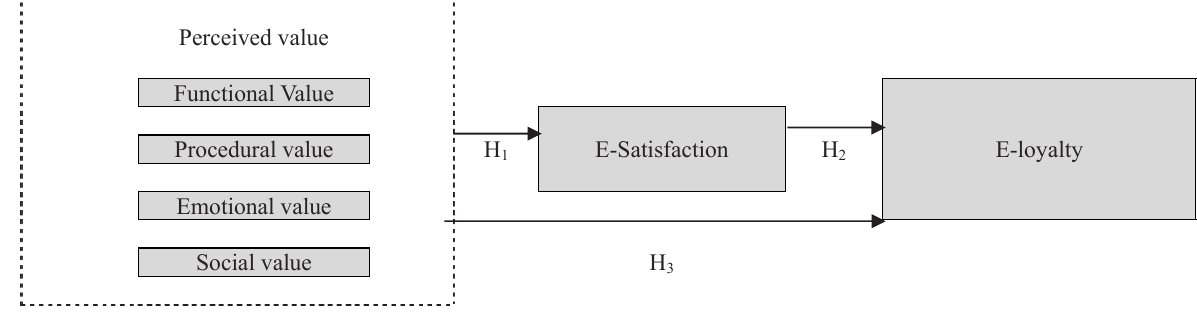
Fig.1. The Conceptual